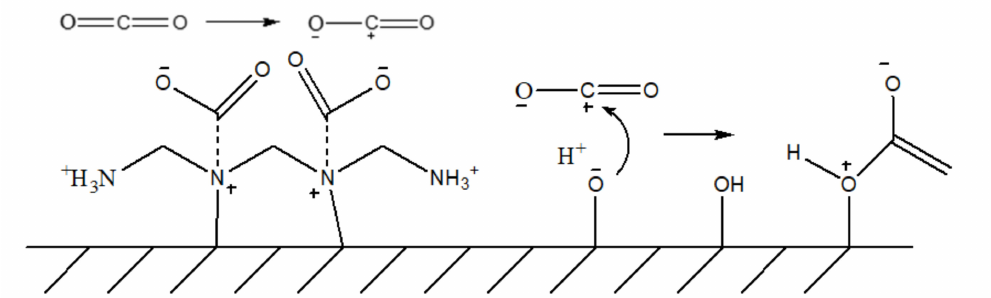
Figure 8. Proposed reaction mechanism between TETA and hydroxide functional groups of AC and CO 2 .